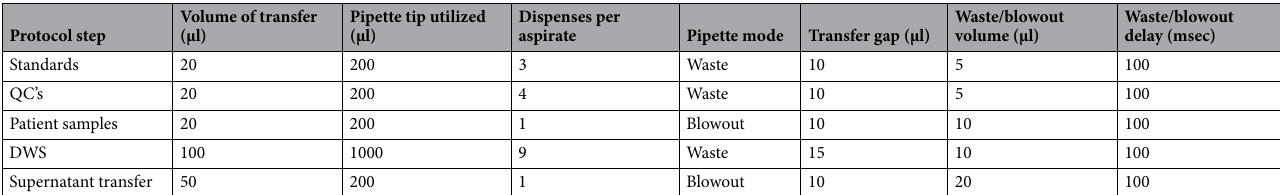
Table 3. Parameters selected for the automation of the proposed protocol (specific to JANUS G3